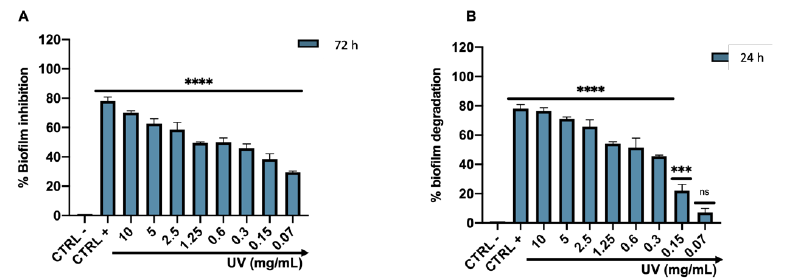
Figure 6. Effect of Arctostaphylos uva-ursi leaf extract on the forming ( A ) and mature ( B ) biofilm of C. acnes after treatment at the concentration range of 10–0.07 mg/mL. Data represent the mean ± standard ANOVA: p -value < 0.0001, R squared = 0.9925. Pharmaceutics 2022 , 14 , x FOR PEER REVIEW